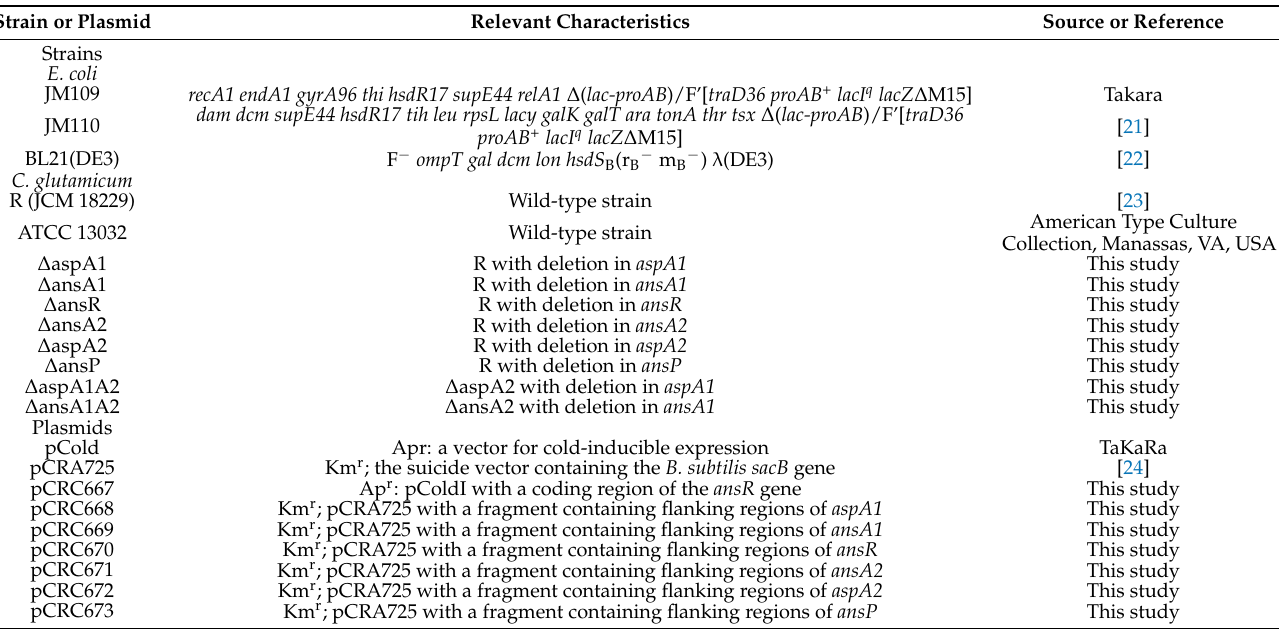
Table 1. Bacterial strains and plasmids used in this